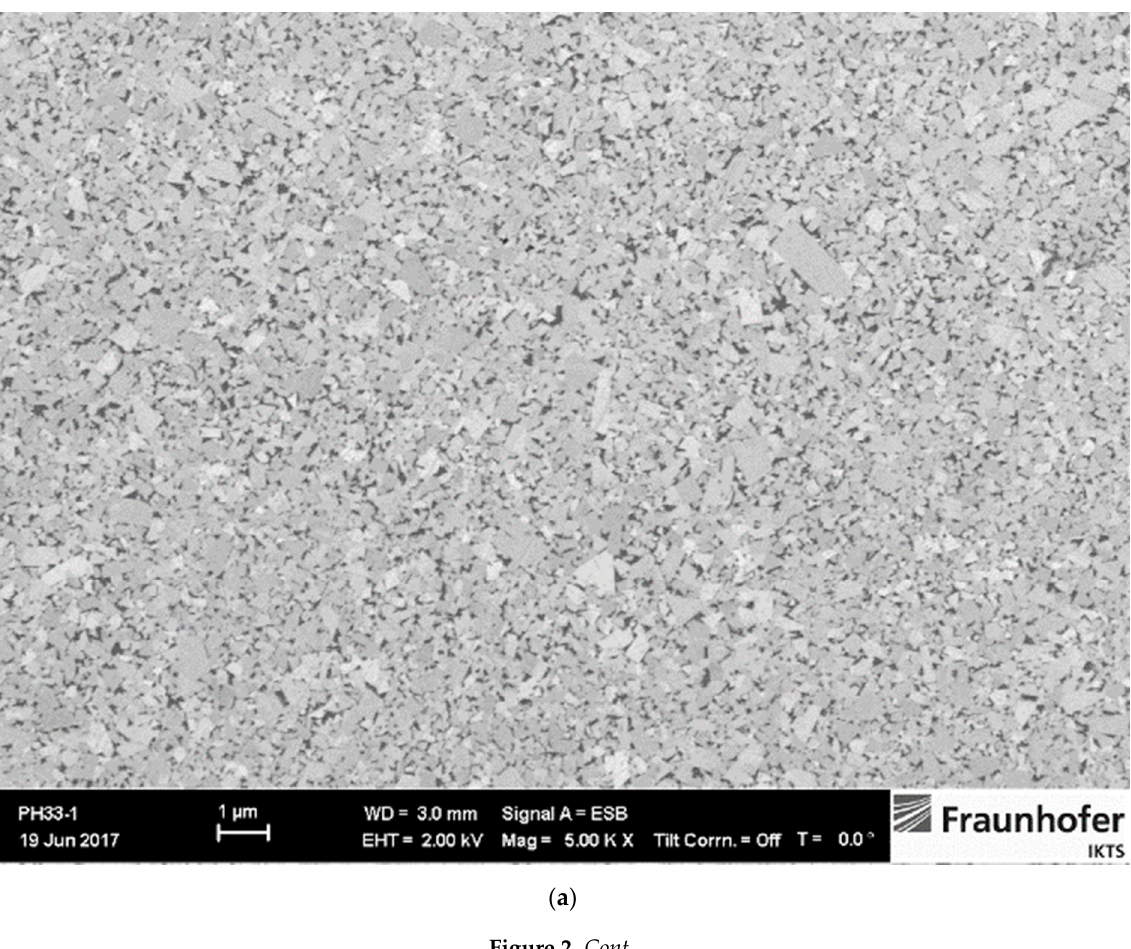
Figure 1. Microstructure and XRD pattern of WC-5Co sample [20]. ( a ) SEM image of microstructure; ( b ) XRD pattern.